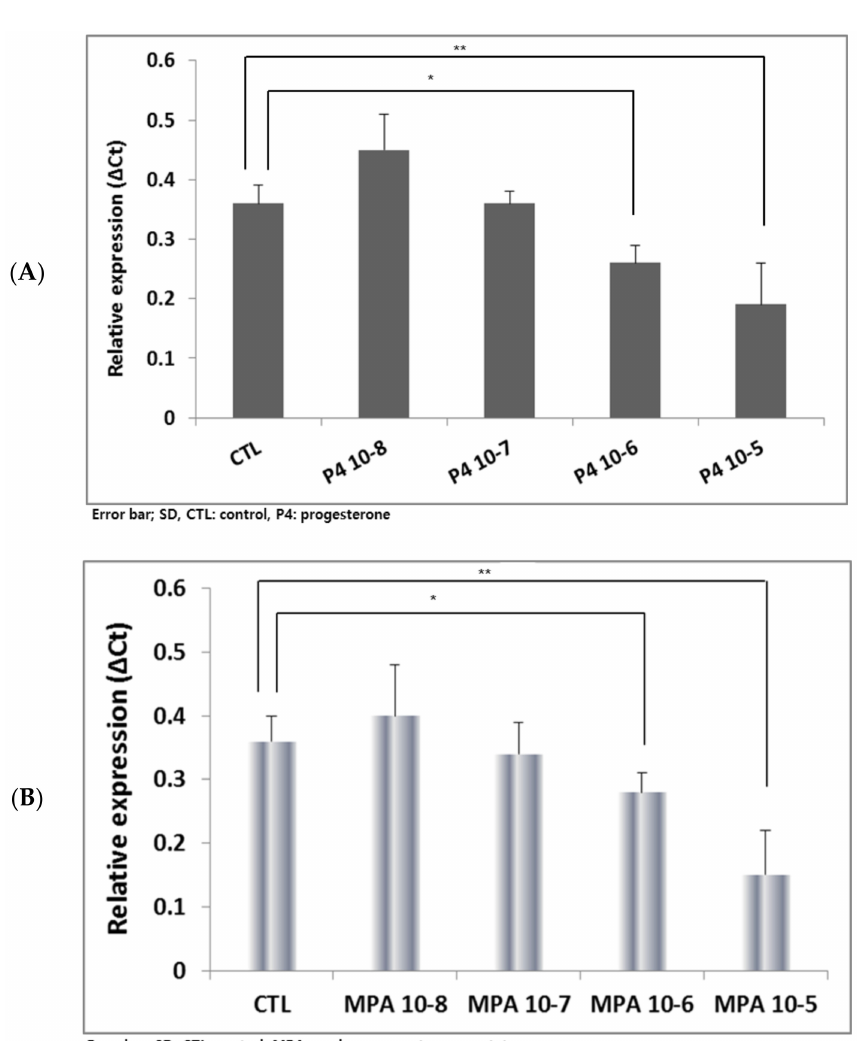
Figure 4. The e ff ects of natural progesterone and synthetic progestin at various concentrations on the expression of α -fetoprotein (AFP) of day 9 hEBs. Treatment of progesterone (P 4 ) or medroxyprogesterone acetate (MPA) of various concentration ranges a ff ected the expression of AFPs , i.e., supraphysiological concentrations such as 10 − 6 M, 10 − 5 M induced a significant down-regulation of AFP expression (* p < 0.05 and ** p < 0.01, respectively) ( A , B